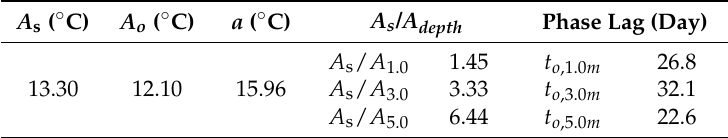
Table 3. Coefficients for estimating the ground temperature in Yeosu, Korea.